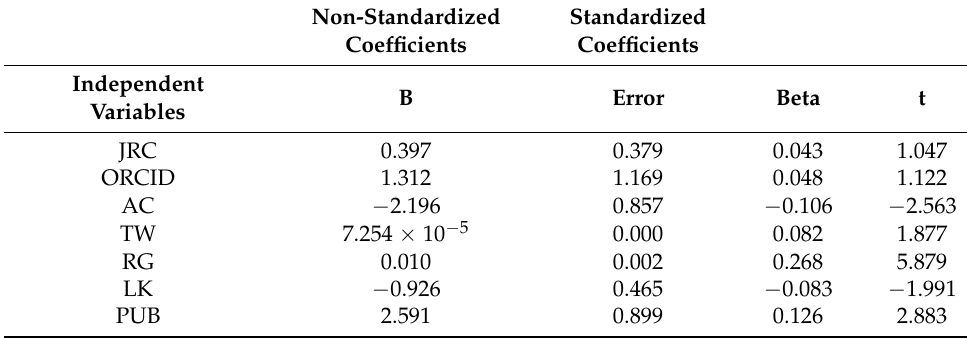
Table 8. Model 2